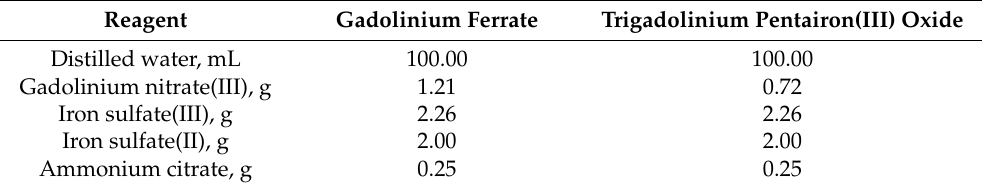
Table 1. Proportion of reagents in the reaction mixture.